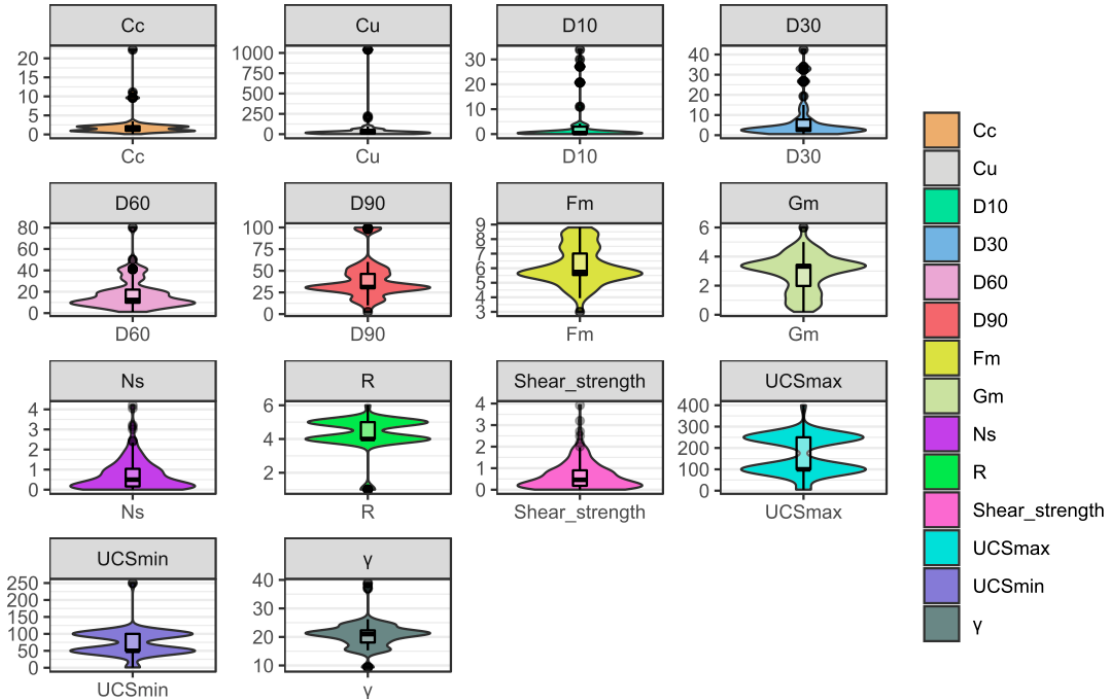
Figure 1. Original data visualization with violin plots.